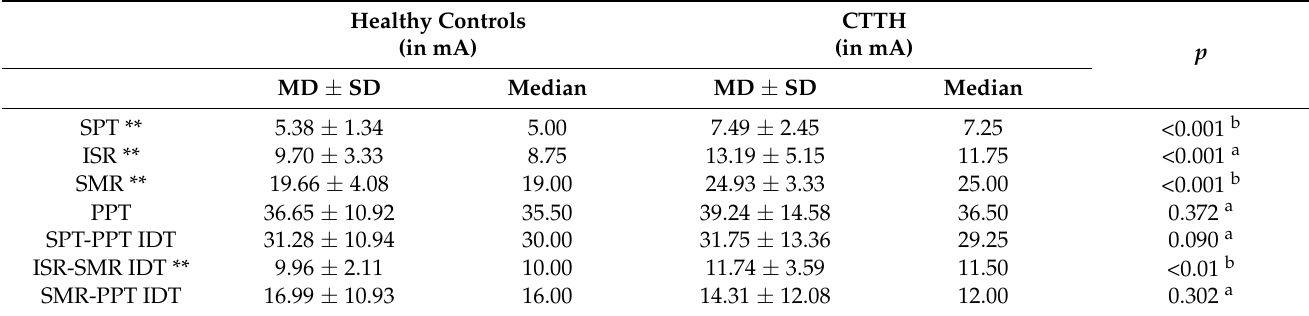
Table 1. Electrical stimuli intensity response thresholds and intensity difference between thresholds in CTTH ( n = 40) and healthy controls ( n = 40).